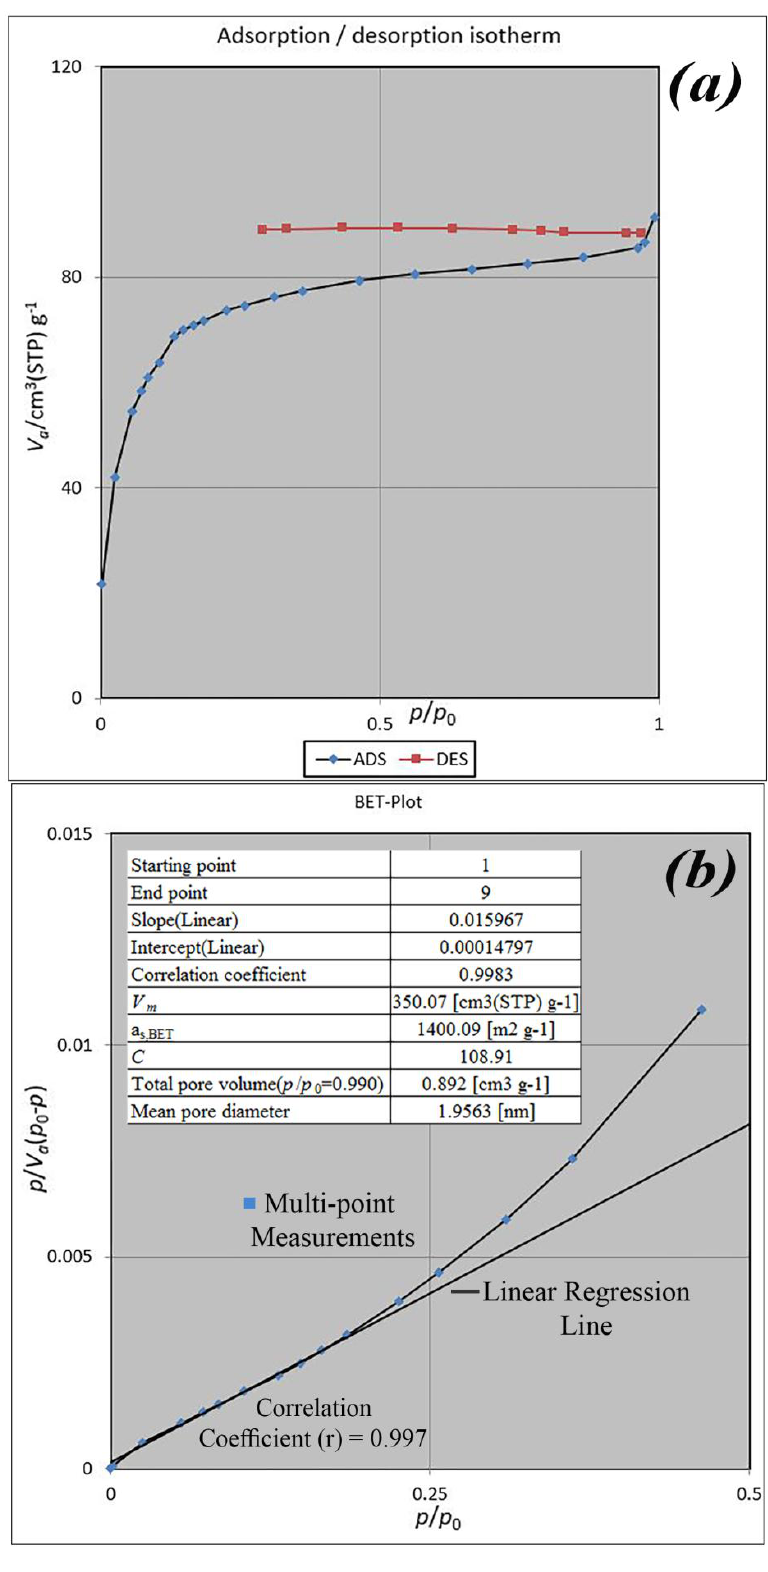
1 Figure 7. Cont